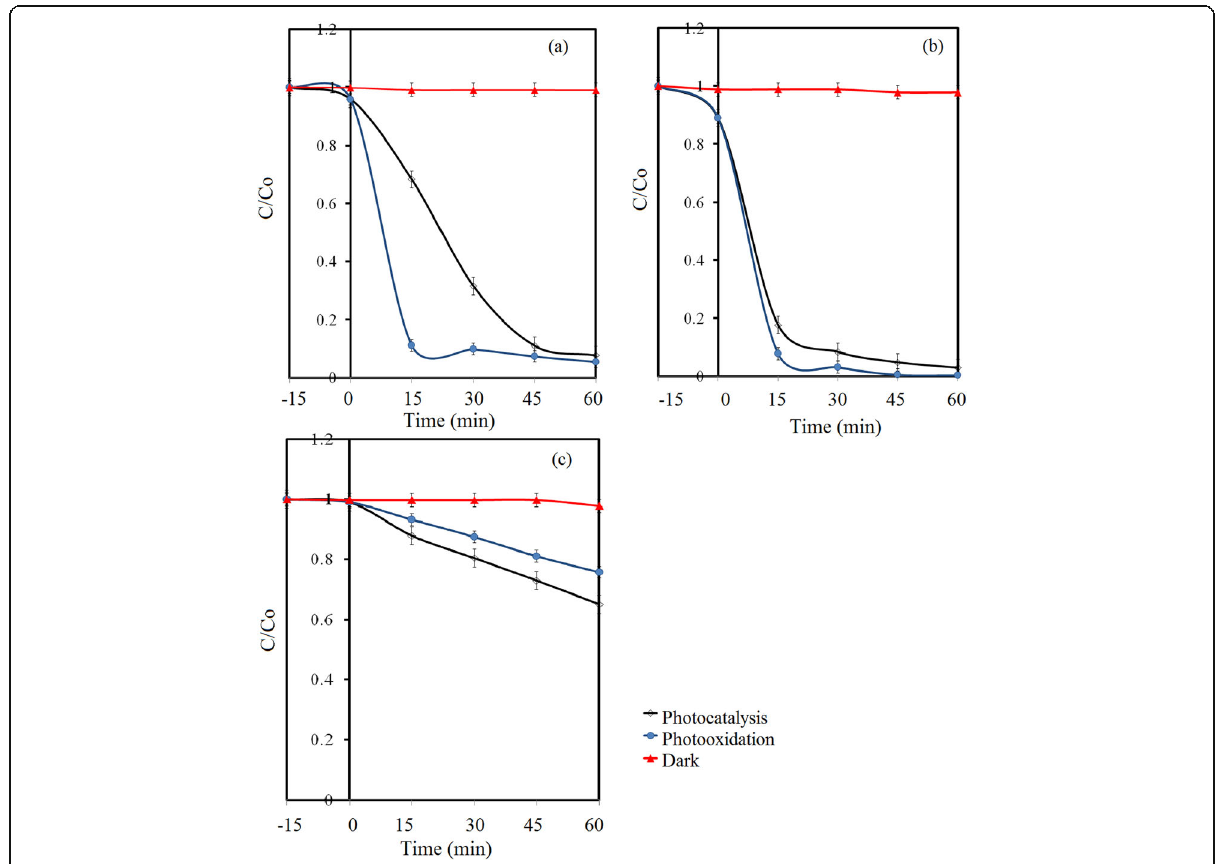
Fig. 6 Kinetics of MV degradation by using ( a ) HAp- n TiO 2 , ( b ) TiO 2 , and ( c ) HAp [Initial MV concentration= 25 mg L − 1 , H 2 O 2 = 10 − 4 M, catalyst dosage= 0.25 g L − 1